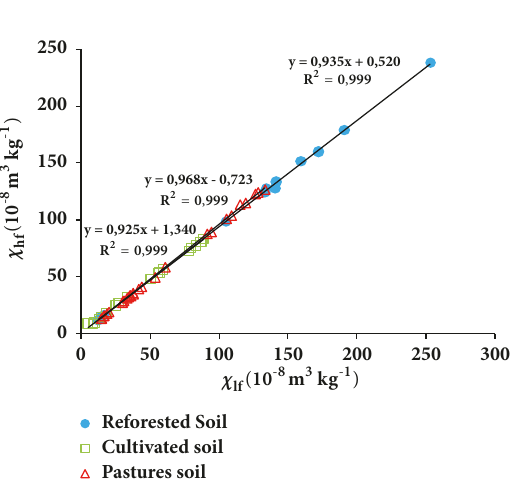
Figure 2: Relation between magnetic susceptibility at high and low frequency in the reforested land, cultivated and pastures